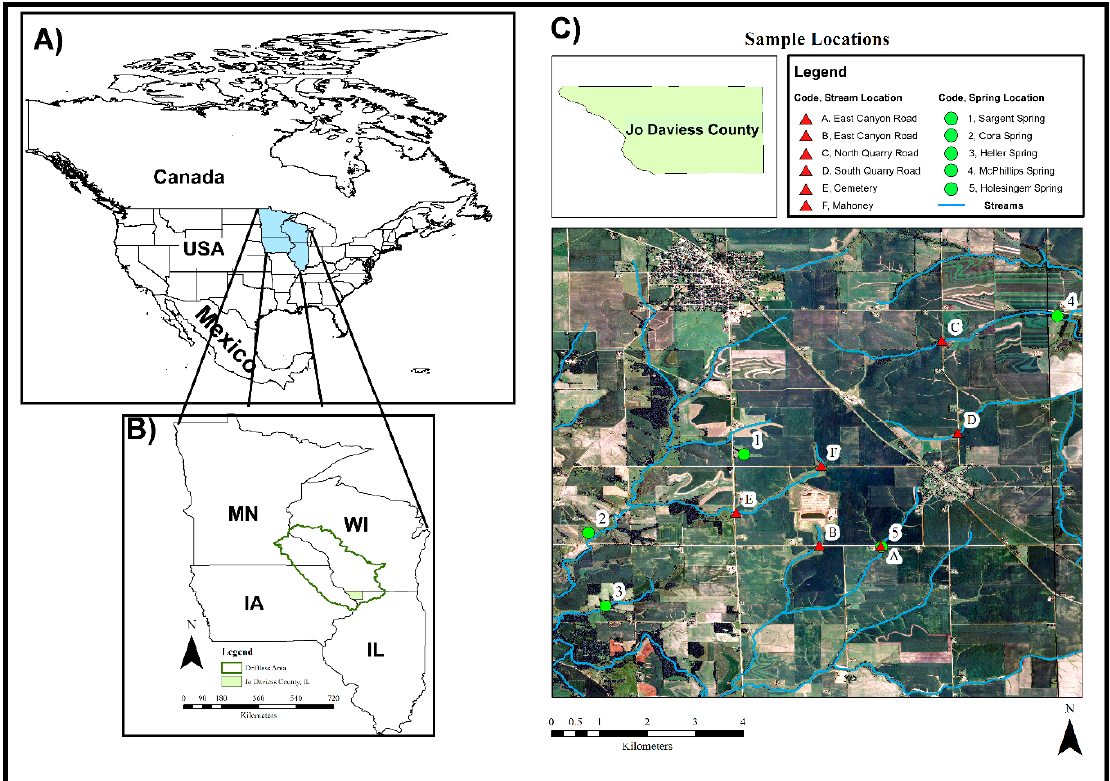
Figure 1. ( A ) Location of the study area within the USA. States shaded blue are presented in inset ( B ). ( B ) Location of the Driftless Area (outlined in green) of northeast Iowa (IA), northwest Illinois (IL), southeast Minnesota (MN), and southwest Wisconsin (WI). Jo Daviess County, the focal area for the study, is shaded green. ( C ). Locations of the streams (red triangles) and springs (green circles) sampled for this study.